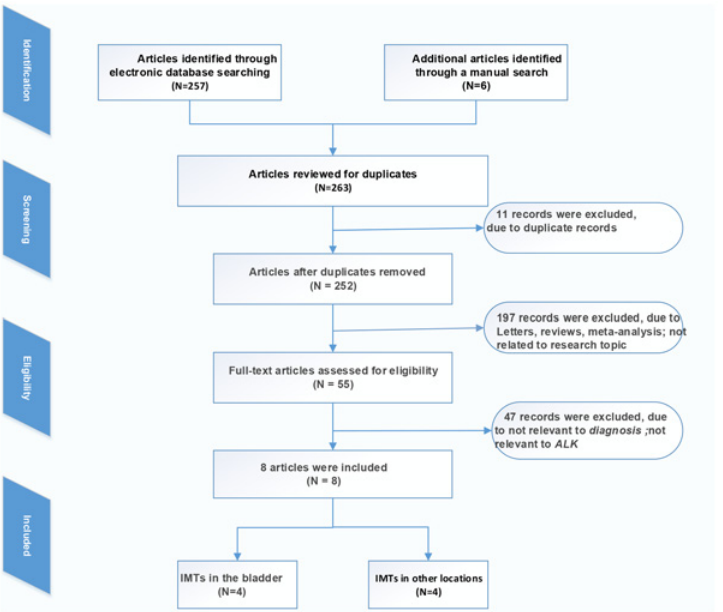
Fig 1. Flow diagram of the study selection process.